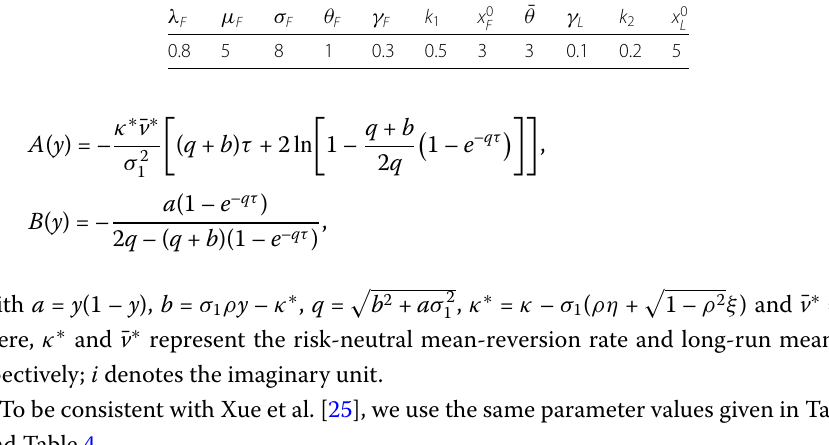
√ V 0 P S 1 (0) ¯ θ γ 0 L k 2 x F L